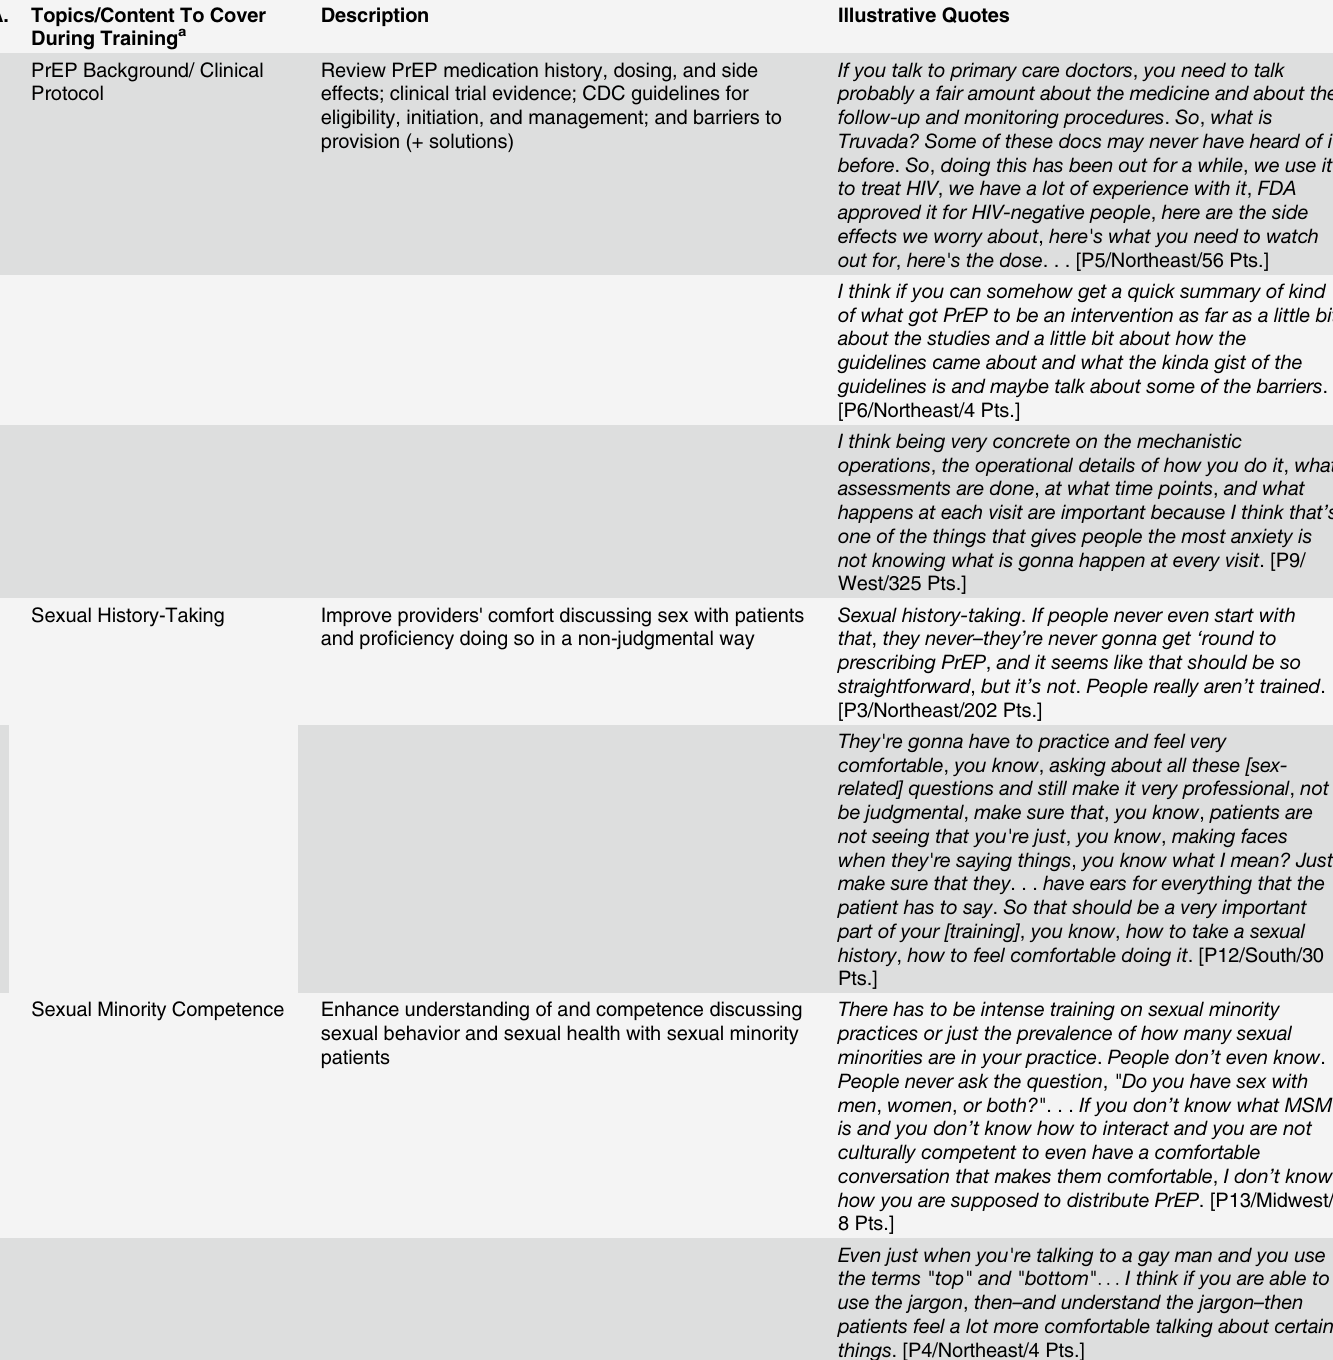
Table 2. Recommendations for Provider-Targeted PrEP Training